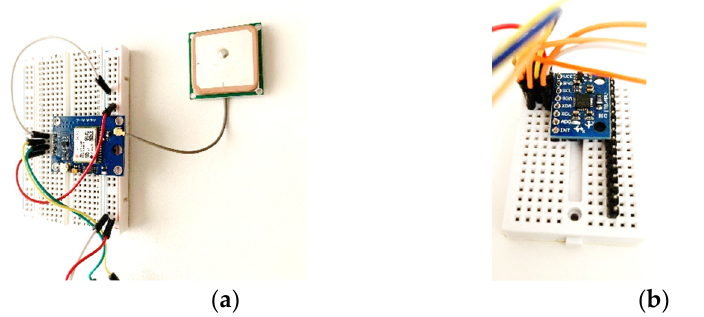
Figure 2. Sensors included in the system: Global Positioning System (GPS) sensor ( a ), and G-sensor ( b ).